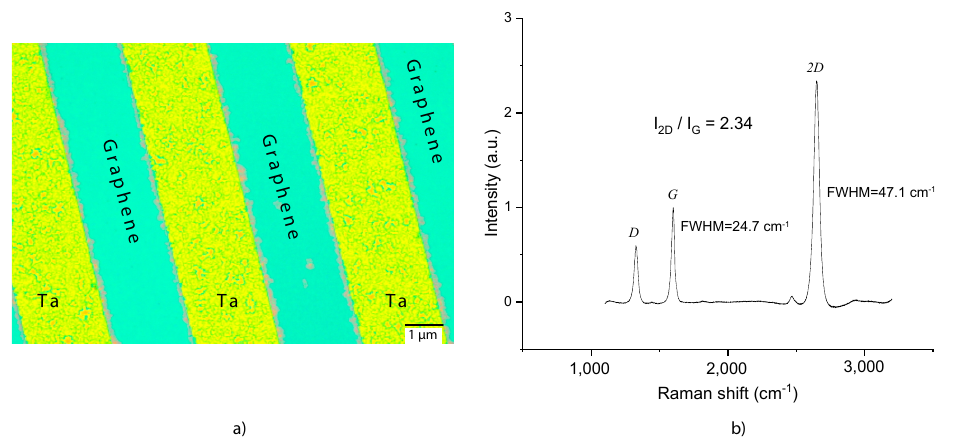
Figure 4. ( a ) Optical micrograph of a wafer with patterned Ta blocking structures (yellow) and transferless CVD graphene (turquoise). The graphene is grown at the interface between the SiO 2 substrate and the Pt seed layer that is removed afterwards. ( b ) Raman spectrum of CVD graphene layer between Ta blocking structures, yielding Raman peak intensity ratios I 2 D / I G = 2.34 and I D / I 2 D = 0.24 and FWHM 2 D ≈ 47 cm − 1 representative for monolayer